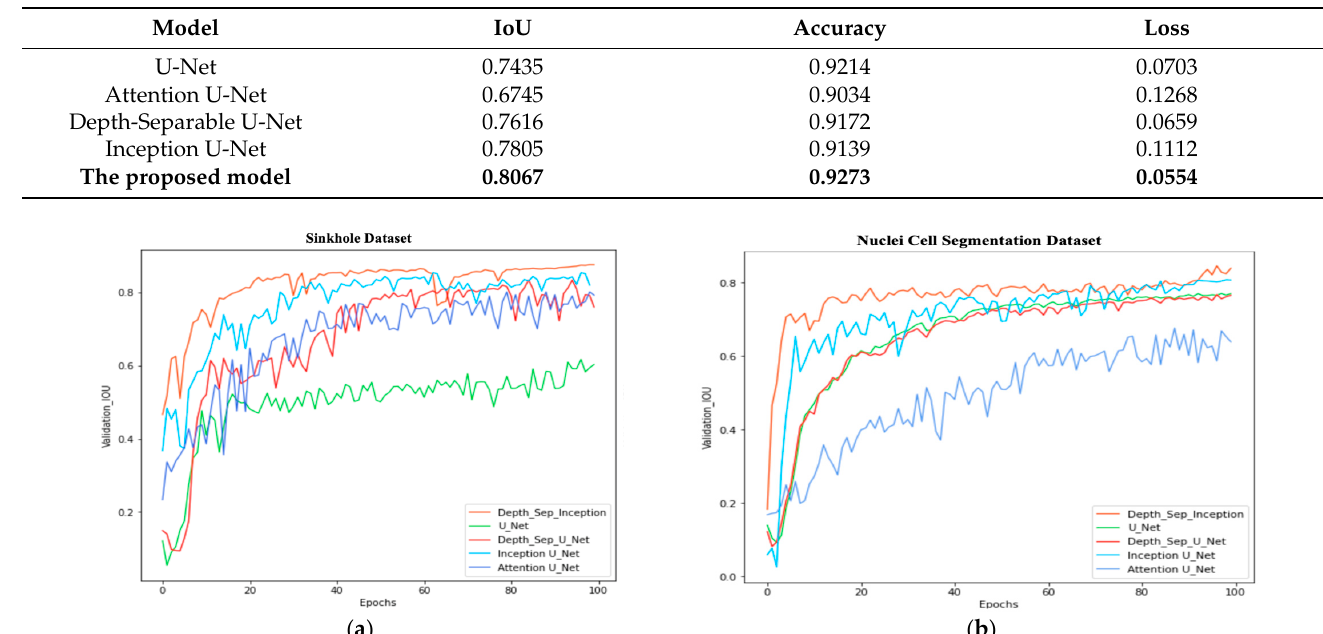
Table 3. Performance Evaluations of the Segmentation Models on the Nuclei Cell Segmenta- tion Dataset.